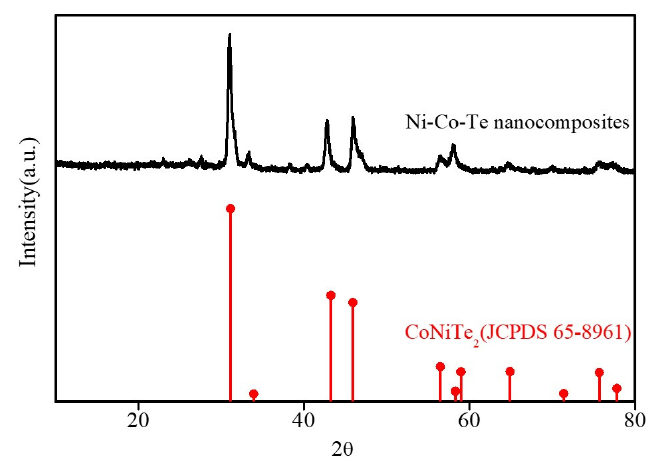
Figure 2. XRD patterns of Ni–Co–Te nanocomposites.